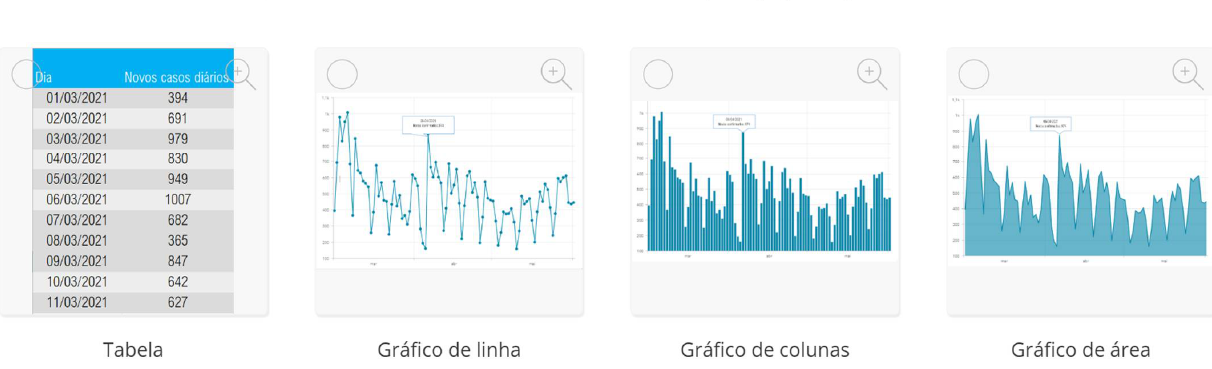
Figure 2. Question 1 of the first part of the Delphi questionnaire. Note: The figure content is written in Portuguese. On top of the figure, Question 1 is posed: (trans. from Portuguese) “Which visualization format do you consider to be the most appropriate to represent a daily number of new confirmed COVID-19 cases, considering three-month time interval (March–June)?”. Below the question, four visualization formats are presented and identified with the following captions (from left to right) Table; Line Chart; Column Chart; Area Chart. The header of the Table provides the number of new COVID-19 cases (right column), by day (left column). The three charts show the number of cases ( y -axis) by day ( x -axis).